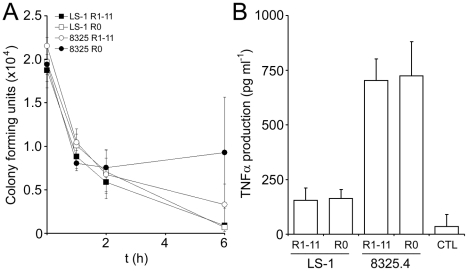
The Fn-binding region of FnBPA does not affect bacterial survival or TNFα production in whole human blood.A. Survival of S. aureus 8325.4 expressing FnBPR1-11 (open circles) or FnBPR0 (closed circles) and LS-1 expressing FnBPR1-11 (closed squares) or FnBPR0 (open squares) in whole human blood over time. Aliquots of blood were assayed for CFU at the indicated time points. Experiments were repeated 3 times. B. Production of TNFα by whole human blood in response to S. aureus strains 8325.4 and LS-1 expressing either FnBPR1-11 or FnBPR0. Samples were taken after 6 hours and TNFα concentration measured by ELISA. Blood incubated in the absence of bacteria served as a negative control (CTL). Experiments were repeated 3 times.